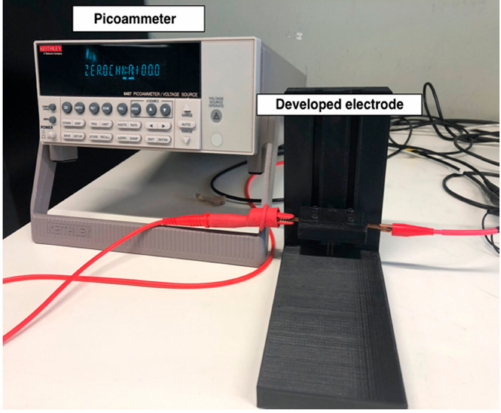
Figure 1. Equipment used for electrical resistance